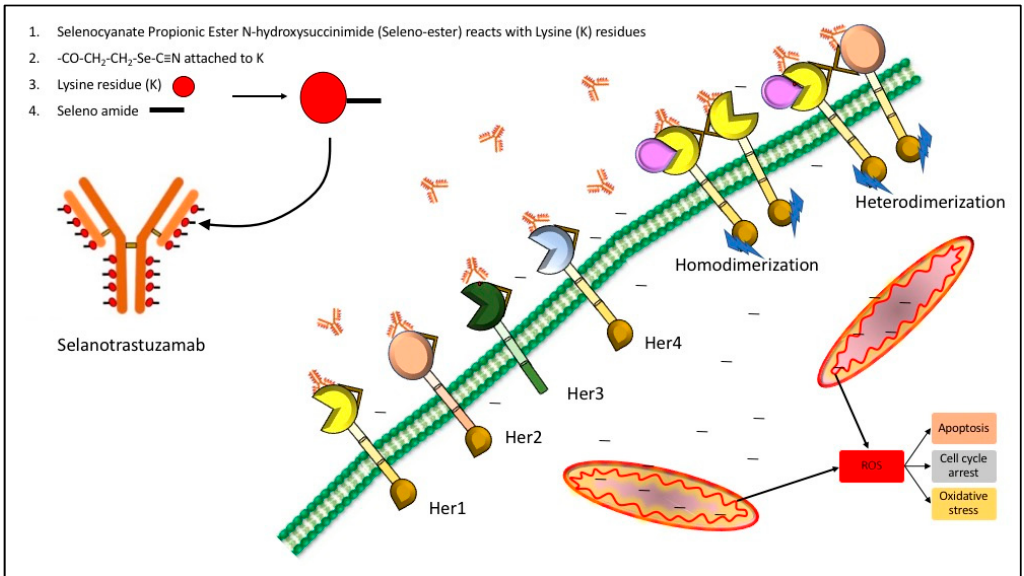
Figure 15. Proposed model of Selanotrastuzamab action. The promiscuity of epidermal growth factor receptor (EGFR) family binding and interaction may be one possible explanation for the observed cytotoxicity in the triple negative breast cancer cells. It is possible for Selanotrastuzamab to interact with other family members, allowing for endocytosis of a critical amount of selenium-bound trastuzumab. The selenium might then become liberated within the cytosol and enter the mitochondria where it disrupts cancer cell metabolism and produces reactive oxygen specieis (ROS).